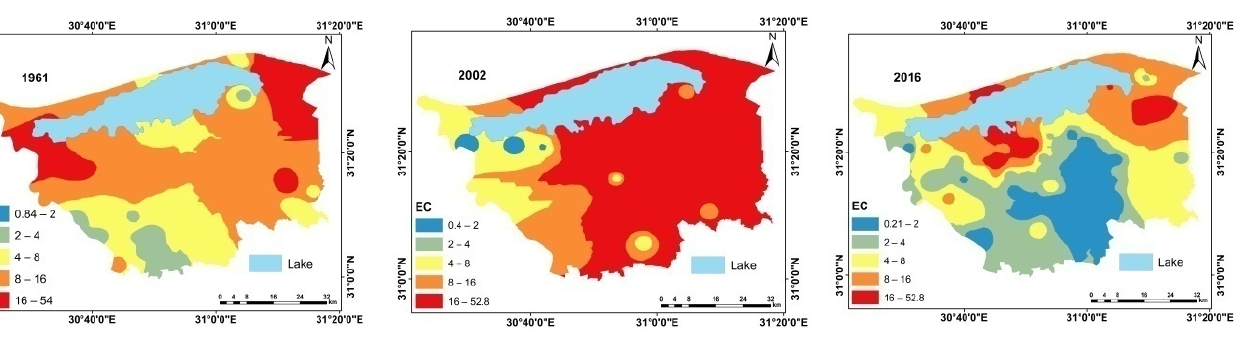
Figure 7. Soil depth maps in 1961, 2002, and 2016.